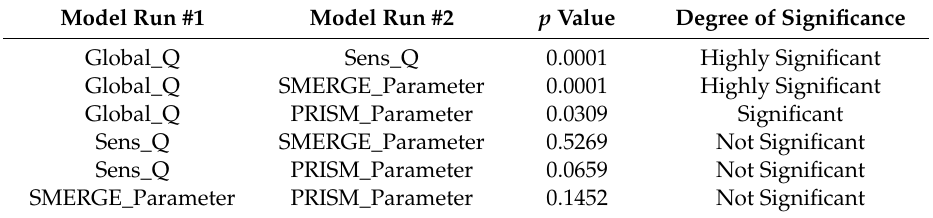
Figure 3. Combined RPS value from global simulation series (1995 to 2015). Red line represents an RPS = 1.00, which is the threshold for an acceptable simulation. Table 10. T-test comparison of mean RPS values from final year-by-year (2016 to 2018) runs.